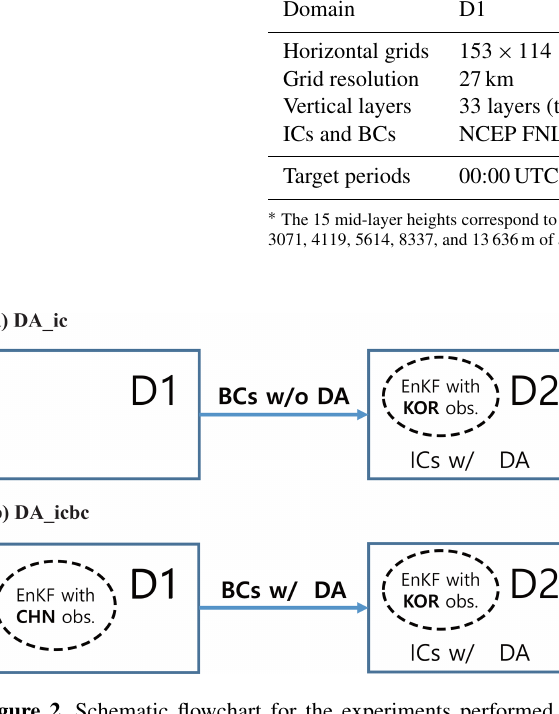
Figure 2. Schematic flowchart for the experiments performed in this study. To evaluate PM 2 . 5 predictability in South Korea, (a) the DA_ic experiment updates the initial conditions (ICs) only within D2, while (b) the DA_icbc experiment provides D2 with updated boundary conditions (BCs) via assimilating ground observations in China (CHN obs.) and also updating the ICs for D2 using Korean ground observations (KOR